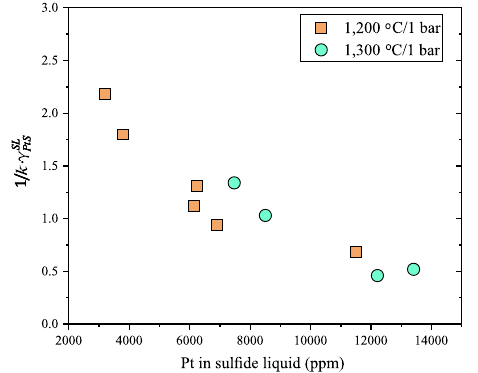
Fig. 3 The calculated activity coef fi cient of PtS ( 1 k (cid:2) γ SL PtS ) as a function of the Pt concentration in the Fe-S-Pt sul fi de liquid. At the same temperature and pressure and similar f S 2 , 1 k (cid:2) γ SL PtS decreases with increasing the Pt concentration in the Fe-S-Pt sul fi de liquid. Note that k is the equilibrium constant of Eq. (6) in the main text. The data used for these calculations were taken from Fonseca et al. 16 . Source data are provided in Supplementary Data 4.